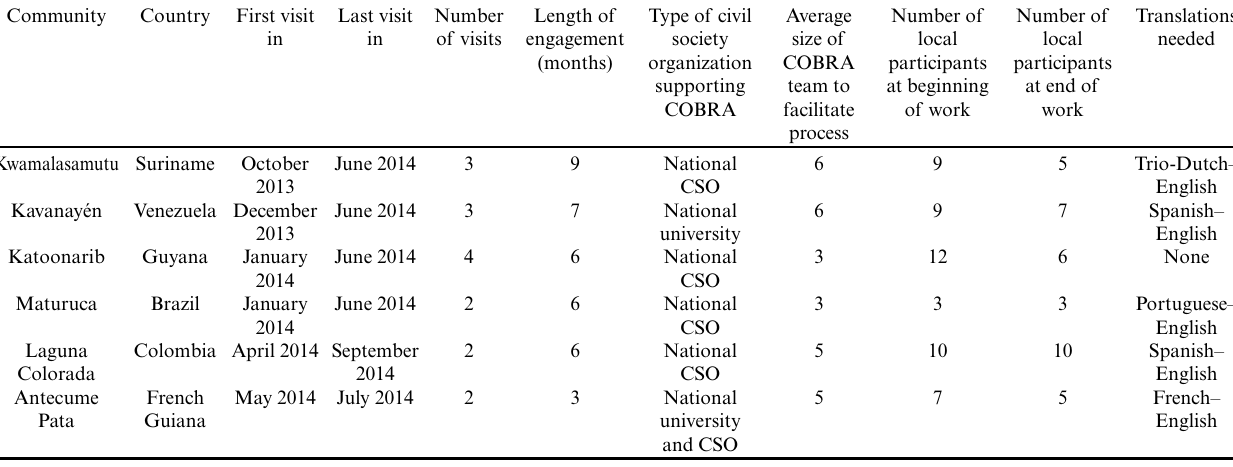
Table 1 . Overview of community engagement during